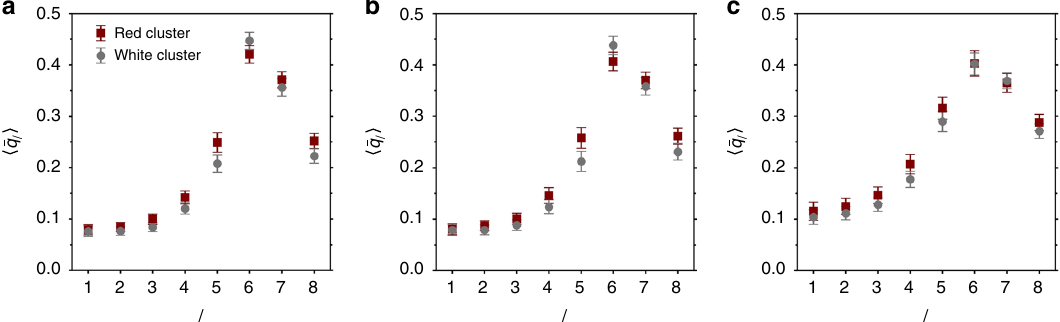
Fig. 6 Variation of bond-order with P red . Mean values of the BOPs for large particles with P red > 0.5 (red) and P red < 0.5 (white) in a hard spheres, b Wahnström, and c Kob – Andersen systems. The state points are the same as in Fig. 2. Bars are the standard deviations. The results for small particles are similar, see Supplementary Fig.